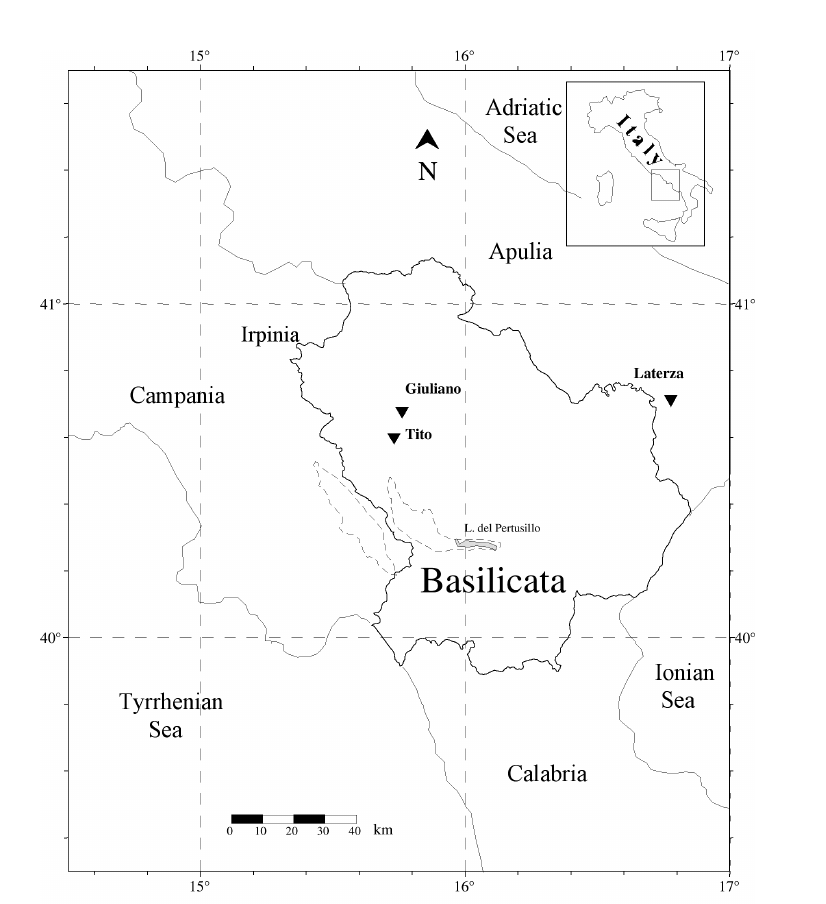
Fig. 1. Location of the geoelectrical monitoring stations Giuliano, Laterza and Tito in Southern